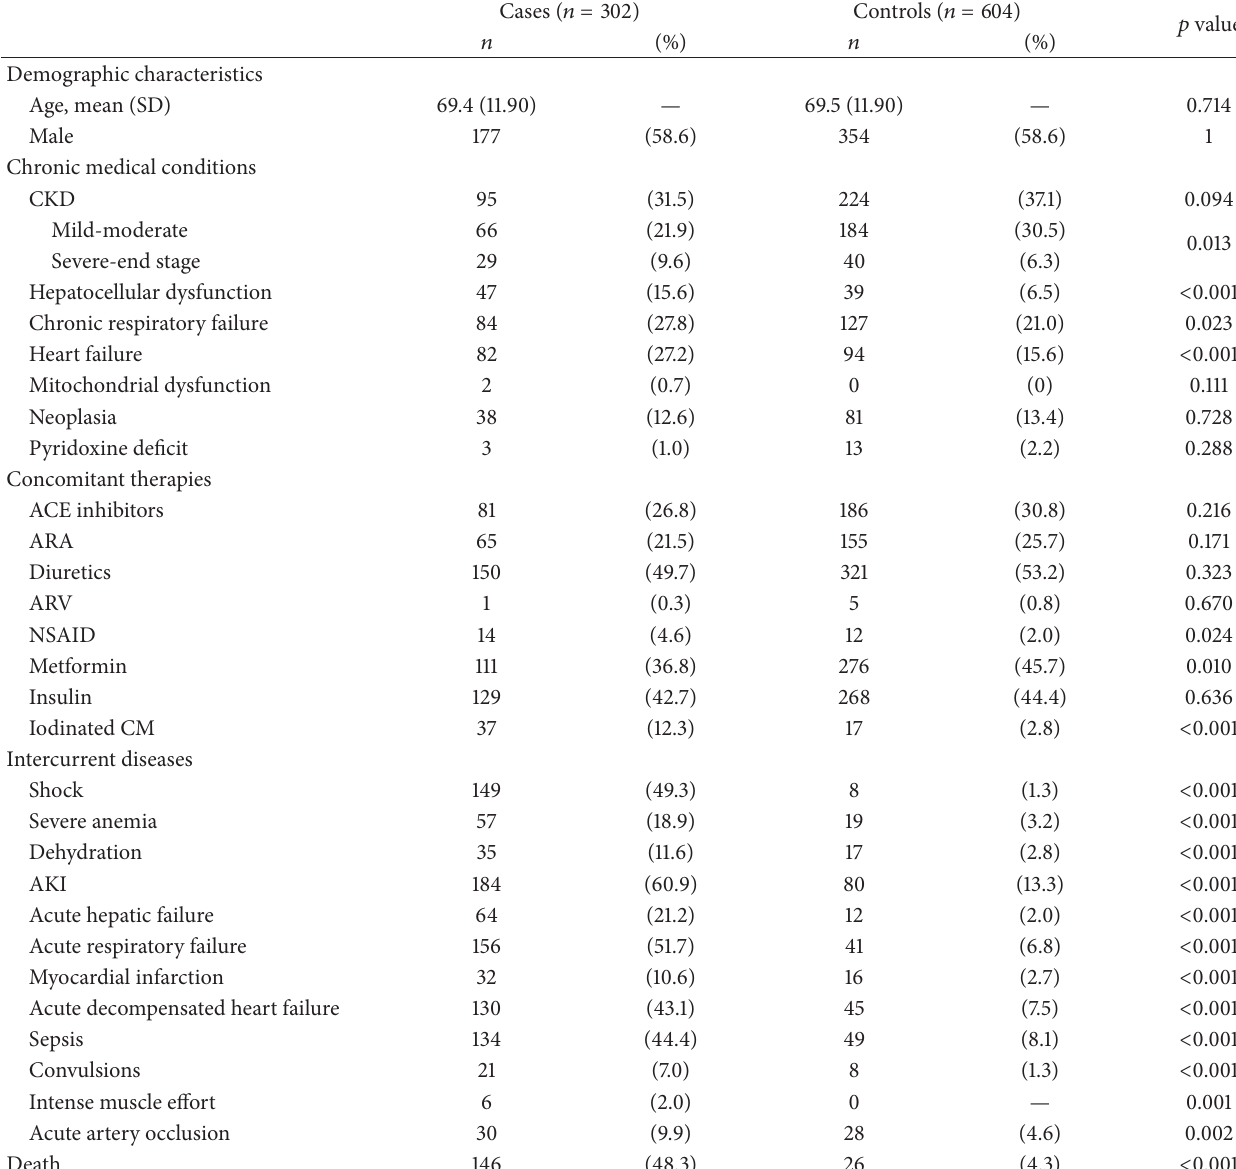
Table 1: Demographic characteristics and comparative analysis of covariates ( 𝑁 = 906